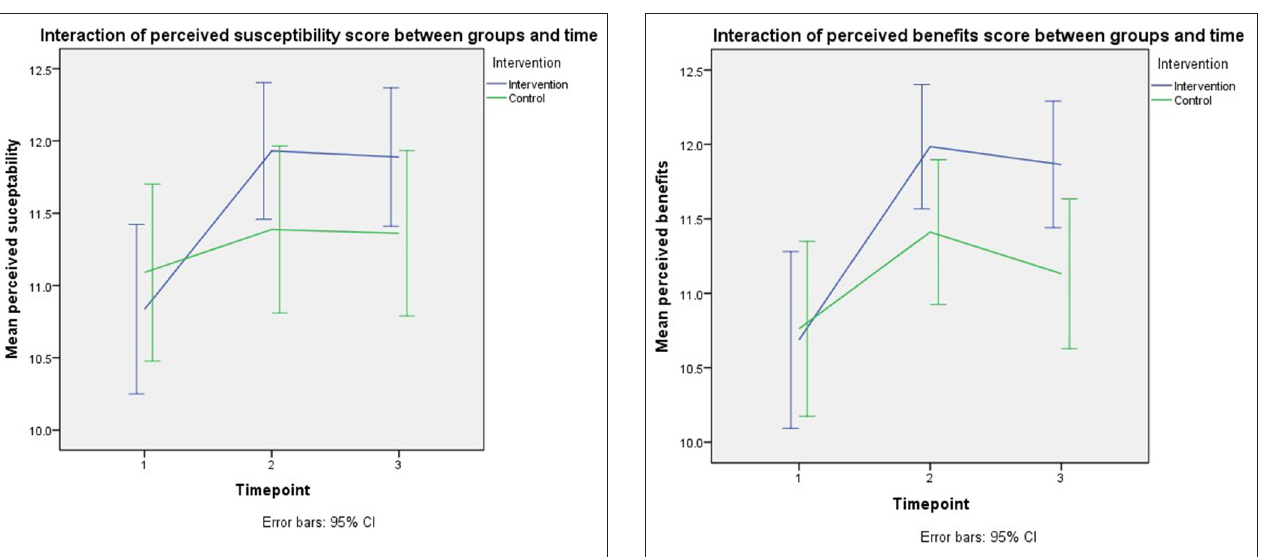
FIGURE 5 | Interaction of perceived benefits scores across groups and